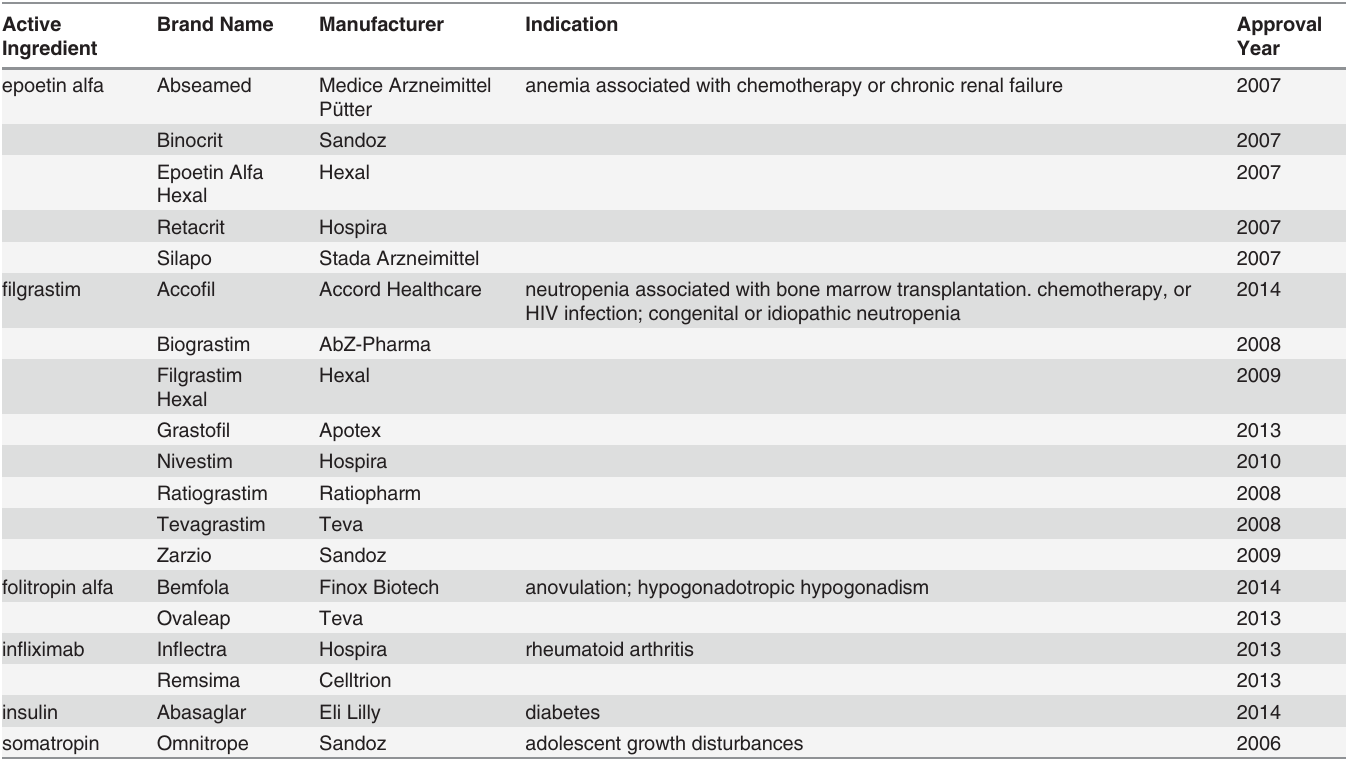
Table 1. Approved follow-on biologics in the EU. Active